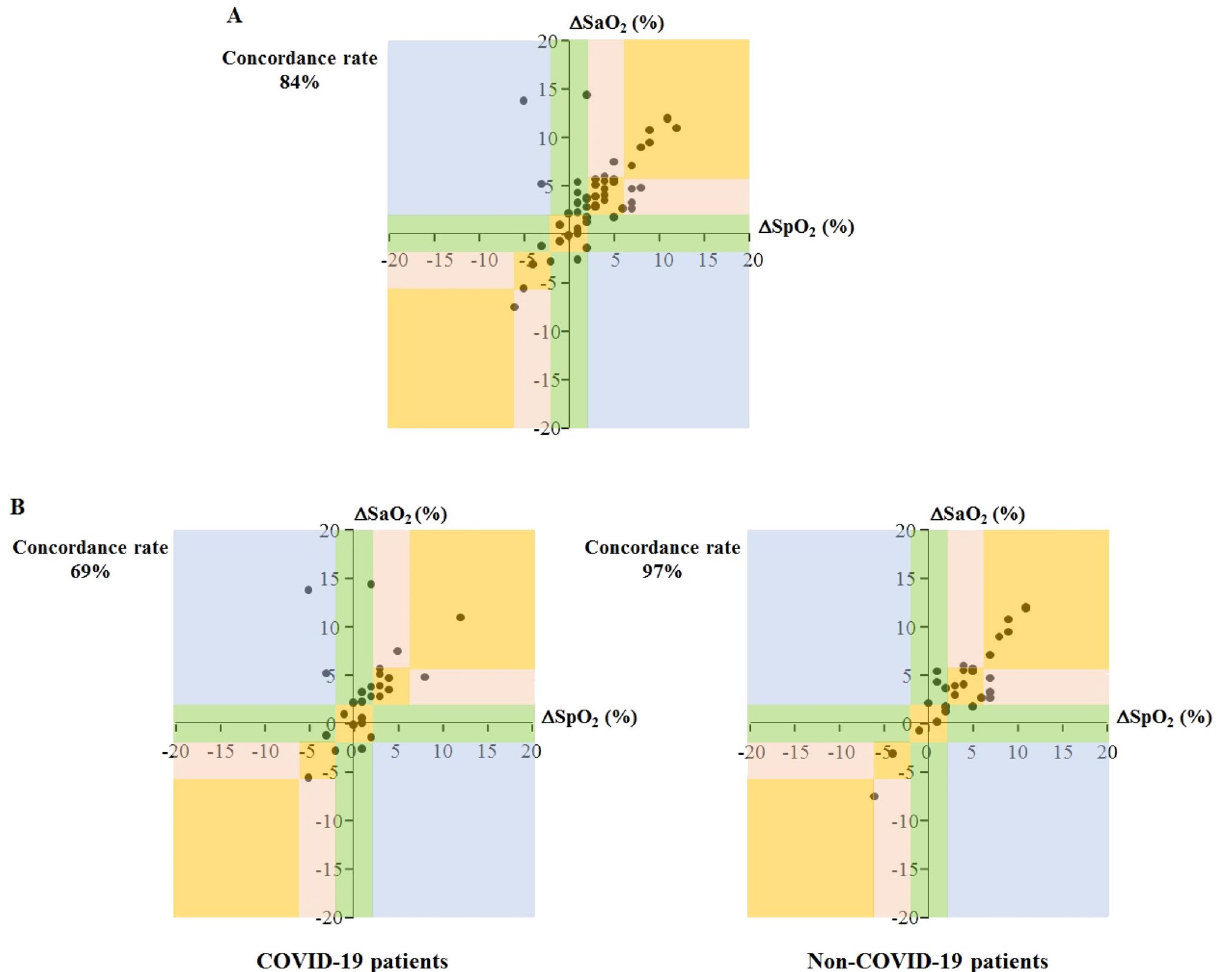
Figure 3. Trending ability of pulse oximetry (SpO 2 ) against arterial oxygen saturation (SaO 2 ) measurements during a positive end-expiratory pressure trial based on four-quadrant concordance analysis. The error grid reflects the therapeutic consequences in specific zones in the concordance plot. Orange zone : ΔSpO 2 and ΔSaO 2 change in the same direction and to the same extent. Pink zone : ΔSpO 2 and ΔSaO 2 change in the same direction but not to the same extent. Green zone : ΔSpO 2 changes while ΔSaO 2 is constant or vice versa. Blue zone : ΔSpO 2 and ΔSaO 2 change in opposite directions. Panel A : in the whole population (n = 55). Panel B : in COVID-19 (n = 26) and non-COVID-19 (n = 29)